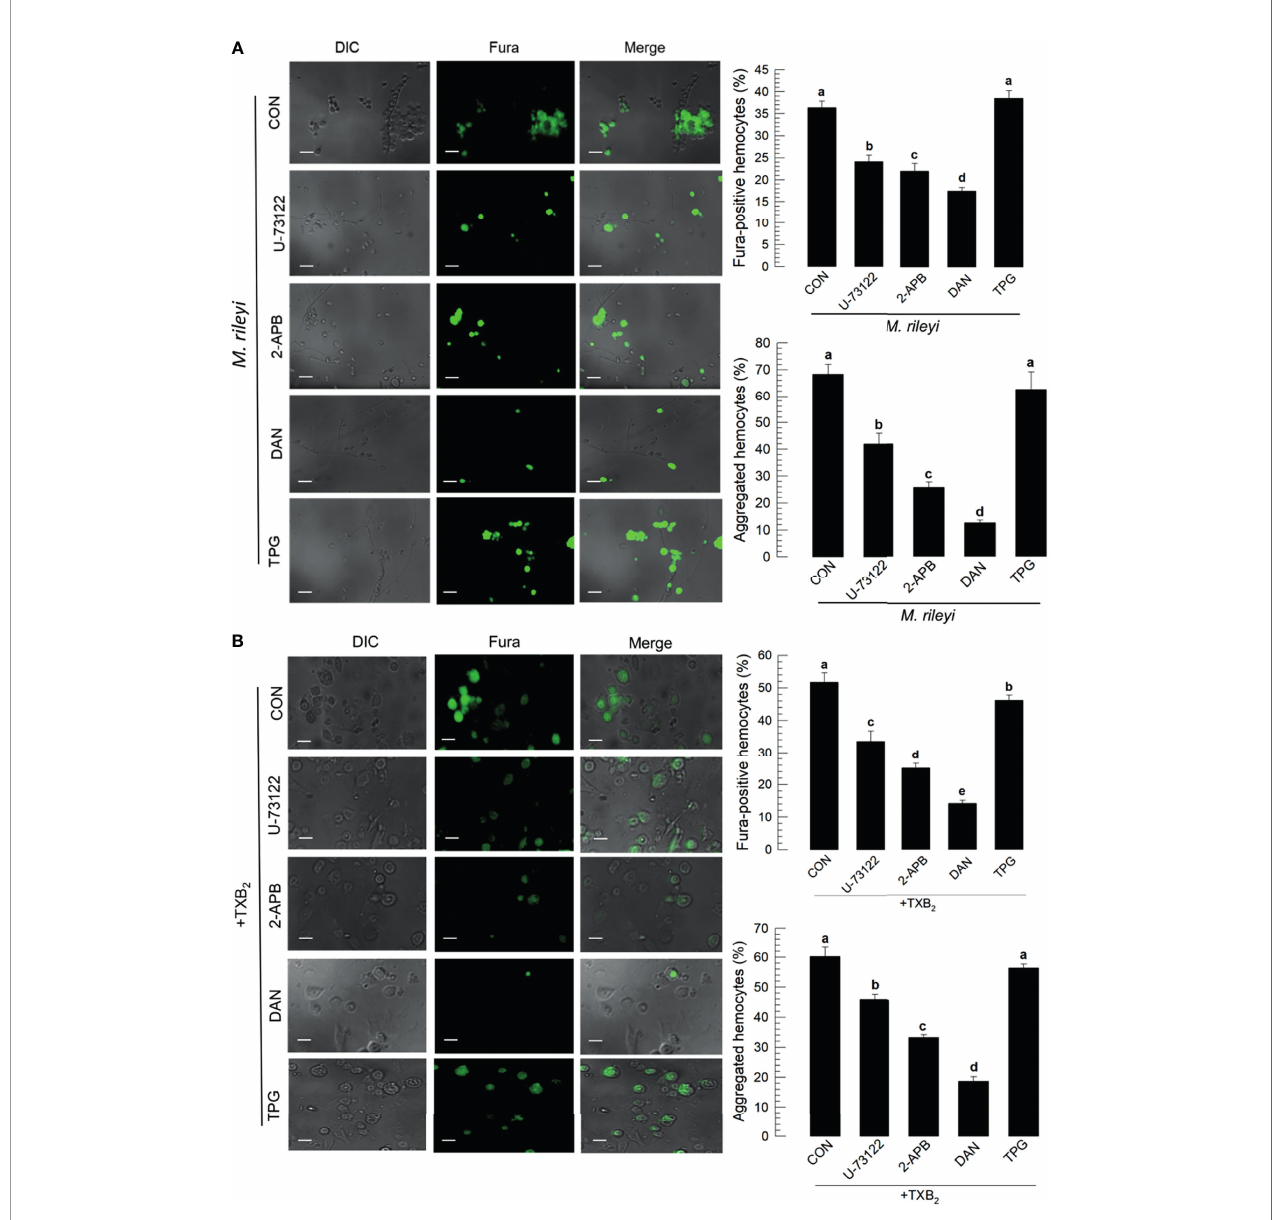
FIGURE 8 | In fl uence of Ca 2+ signaling inhibitors on Ca 2+ signaling in S. exigua hemocytes. Panel (A) depicts the in fl uences of separate treatments with DAN, a ryanodine receptor inhibitor, 2-APB an IP 3 receptor inhibitor, U-73122, a PLC inhibitor, and TPG, a SERCA inhibitor on proportions of Fura-positive hemocytes and proportions of aggregated hemocytes following M. rileyi injections. The micrographs show Fura-positive hemocytes and the accompanying histograms present the results in quantitative terms. Panel (B) indicates the negative in fl uence of the Ca 2+ signaling inhibitors was not rescued by TXB 2 treatments. CON represents the fungal infection or TXB 2 alone. Each treatment was replicated three times. Data analyzed and presented as described in Methods . Different letters above standard deviation bars indicate signi fi cant difference among means at Type I error = 0.05 (LSD